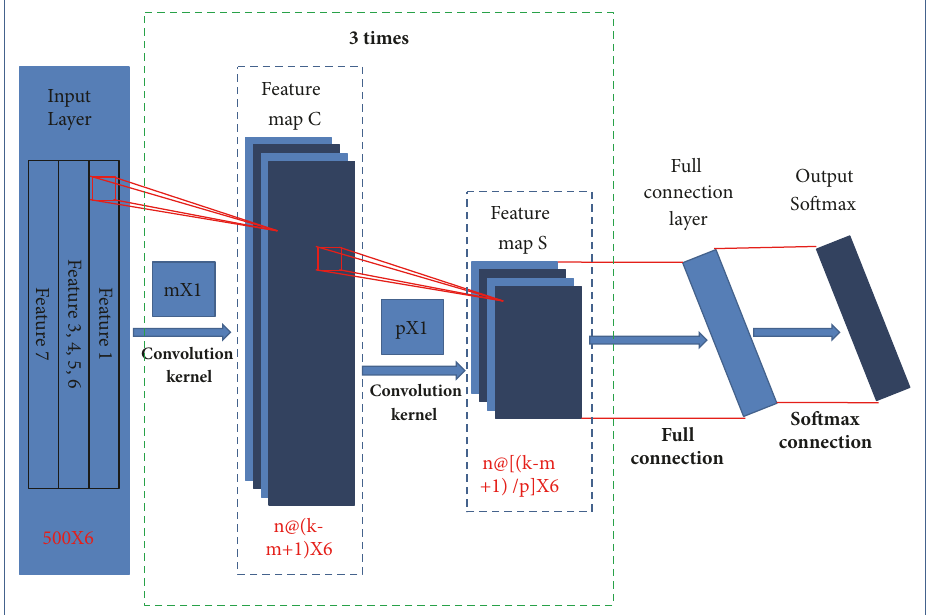
Figure 4: The designed CNN for video popularity prediction.